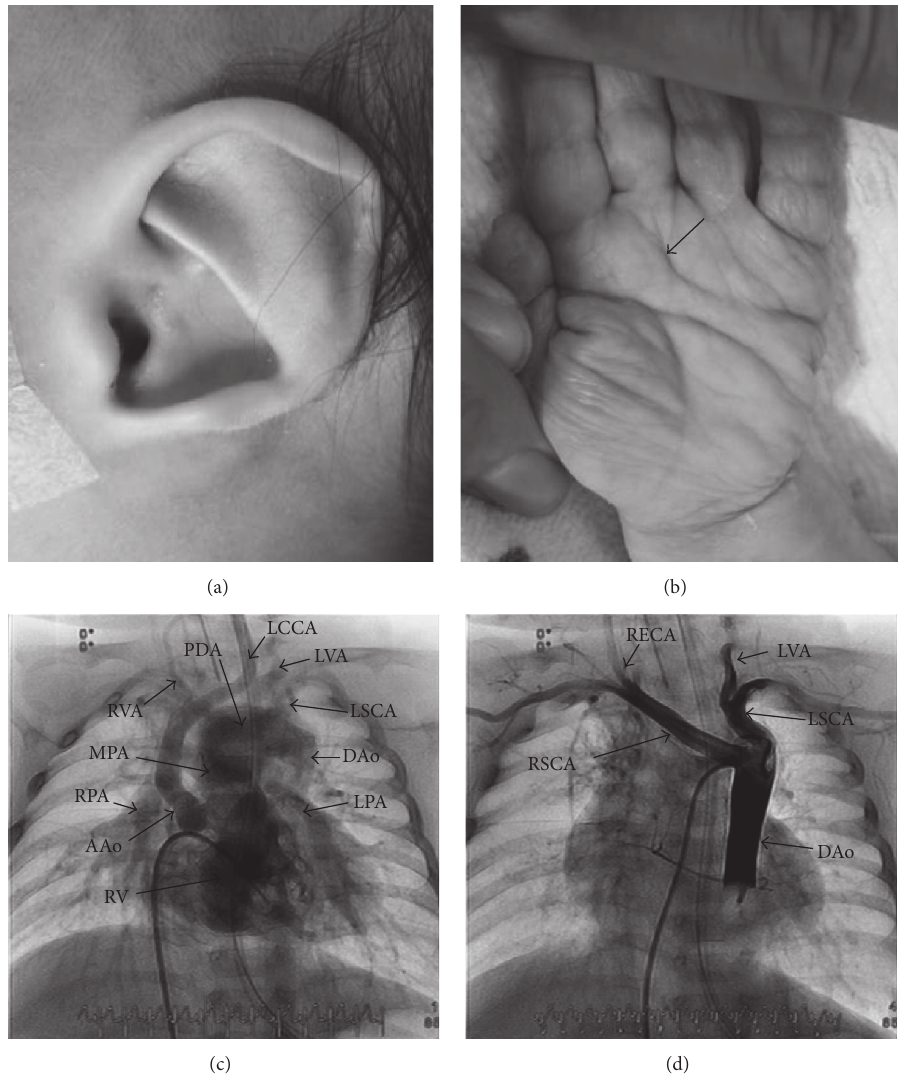
Figure 2: Dysmorphic features and cardiovascular malformations in Case 2. (a) “CHARGE ear.” (b) Hockey-stick palmar crease (arrow). (c) Right ventriculography demonstrated double outlet right ventricle, interrupted aortic arch type B, and hypoplastic ascending aorta. (d) Descending aortography with balloon occlusion. Note aberrant origin of the right subclavian artery. AAo, ascending aorta; DAo, descending aorta; LCCA, left common carotid artery; LPA, left pulmonary artery; LSCA, left subclavian artery; LVA, left vertebral artery; MPA, main pulmonary artery; PDA, patent ductus arteriosus; RECA, right external carotid artery; RPA, right pulmonary artery; RSCA, right subclavian artery; RV, right ventricle; RVA, right vertebral